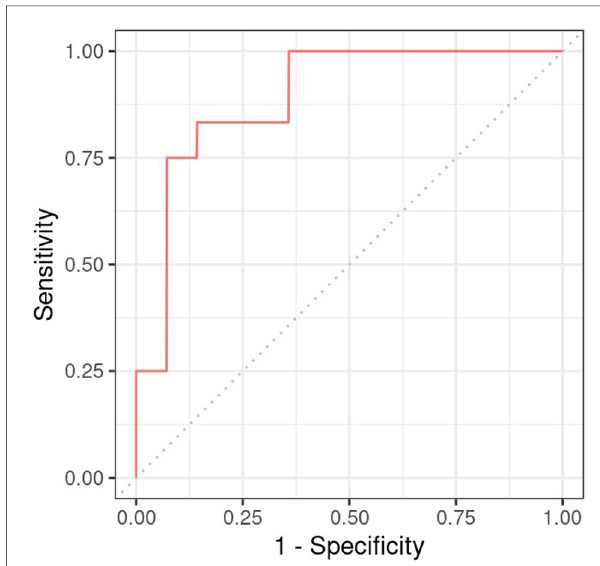
FIGURE 7 Receiver operating charateristics curve of the regression model constructed for neurodevelopmental outcome with heart rate during hypothermia as